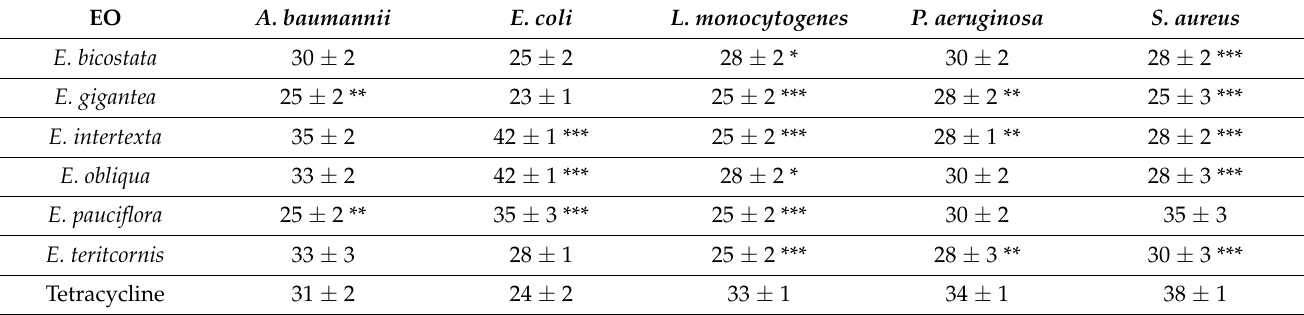
Table 5. MIC ( µ L/mL) of the six Eucalyptus EOs necessary to inhibit the growth of A. baumannii , E. coli